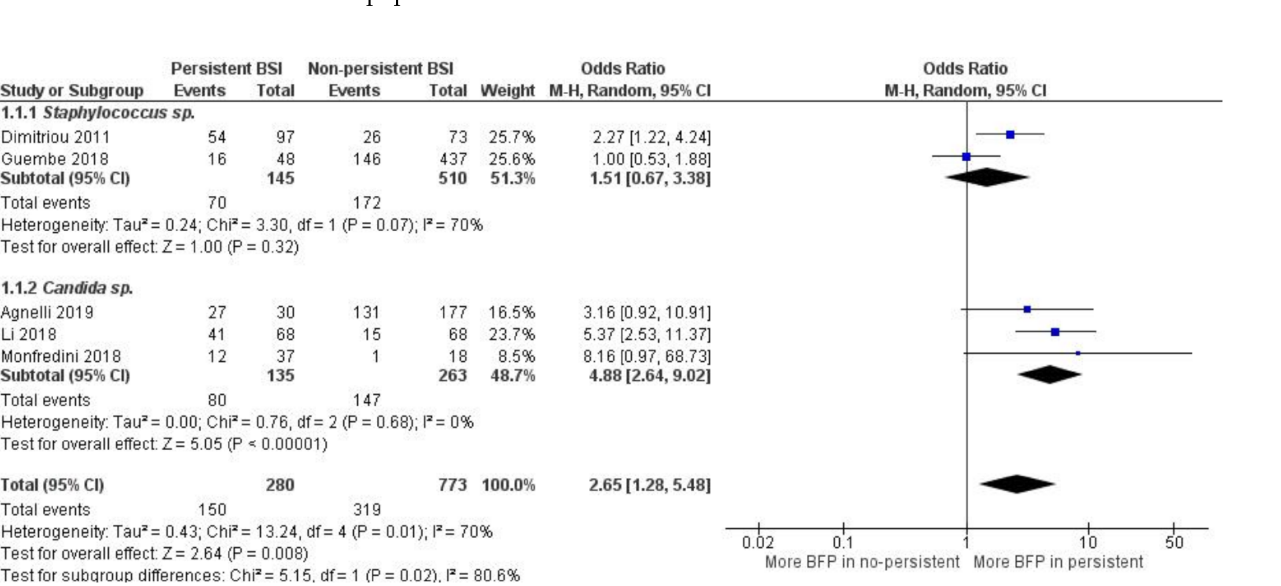
Figure 4. Forest plot of BFP (biofilm production) prevalence in persistent vs. non-persistent BSIs (Bloodstream Infections), and subgroup analysis by microorganism. “Tau 2 ” represents the absolute value of the true variance (amount of heterogene- ity). “Chi 2 ” is the chi-squared test of the null hypothesis that there is no heterogeneity.”df” are degrees of freedom. “P” represents the p -value. The “I 2 ” statistic describes the percentage of variation across studies that is due to heterogeneity rather than chance. “Z” is the z-statistic, which are significance tests for the weighted average effect size. “CI” stands for confidence interval. “M-H” is the Mantel-Haenszel analysis